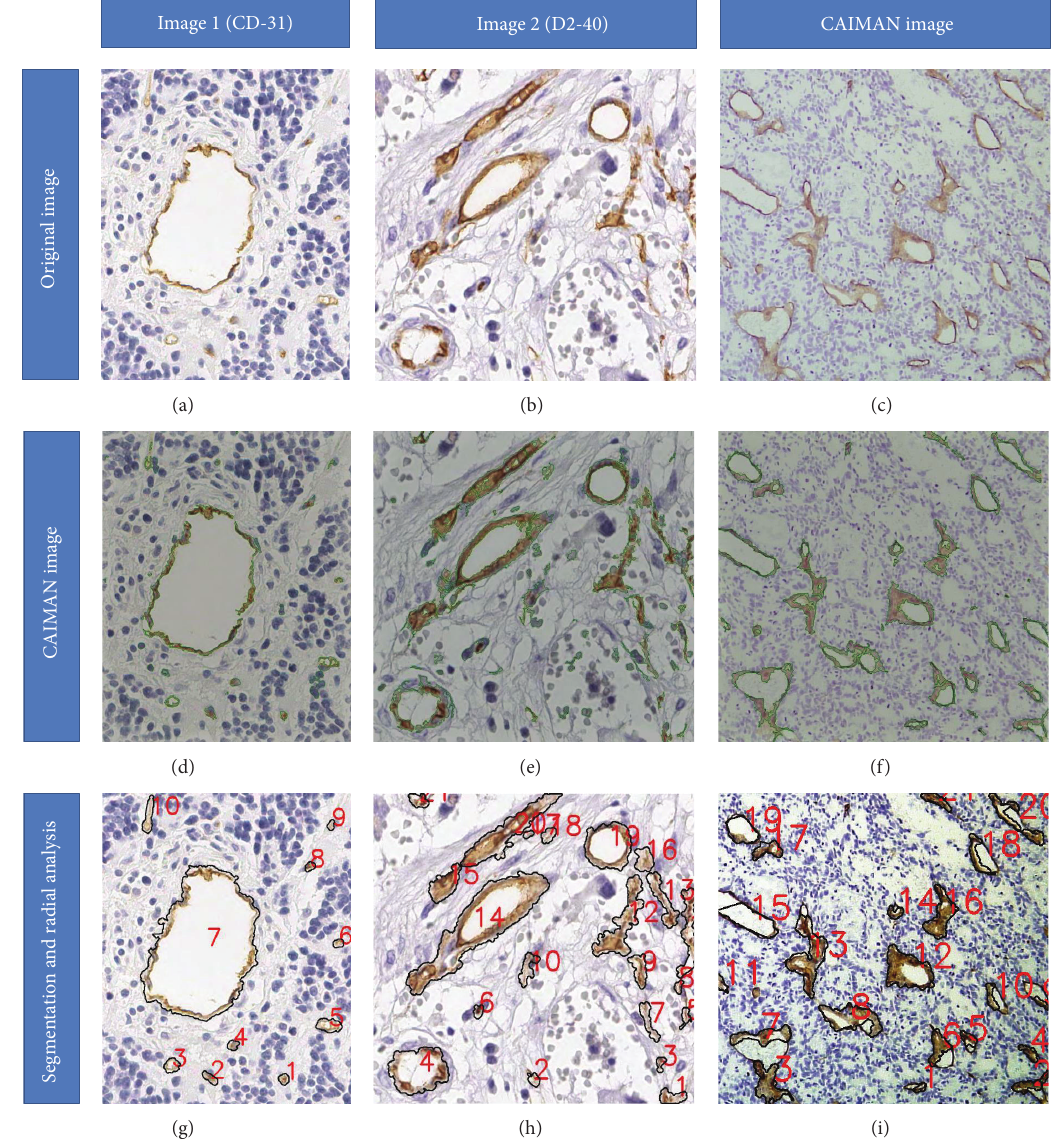
Figure 9: CAIMAN application. (1st row) original images: (a) and (b) are images from our database and (c) is an example image provided by CAIMAN with a less-lighted caption. (2nd row) segmentation performed by CAIMAN (green line) which does not detect small or too large vessels (d) and sometimes divide large vessels in small ones or segment blue areas as vessels (e). Their image is well segmented (f). (3rd row) results provided by AngioPath with the color-based segmentation and the radial